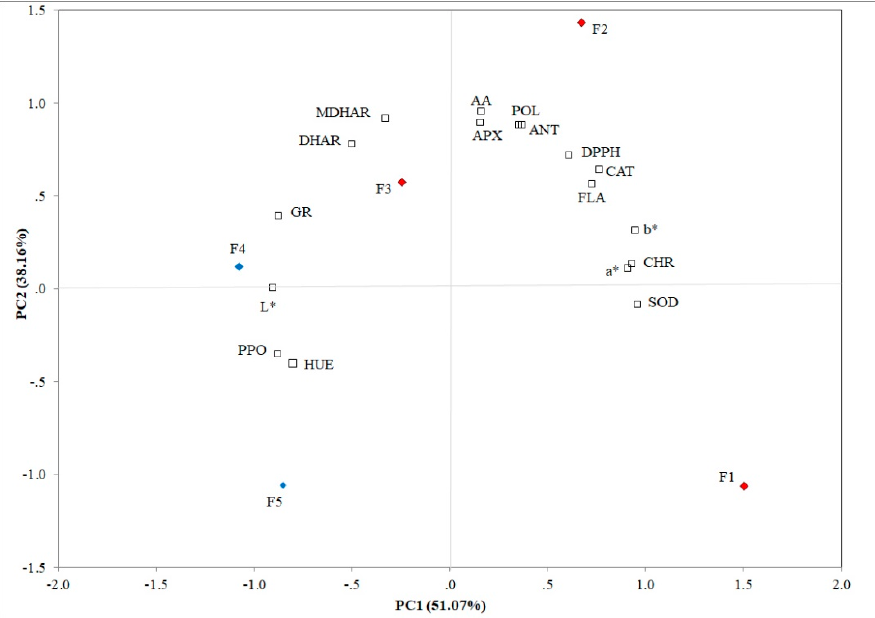
Figure 5. Principal component analysis of the physicochemical, bioactive, and enzymatic traits in in five different flowering stage of feijoa (F1, F2, F3, F4, F5) (POL: total polyphenol content; AA: ascorbic